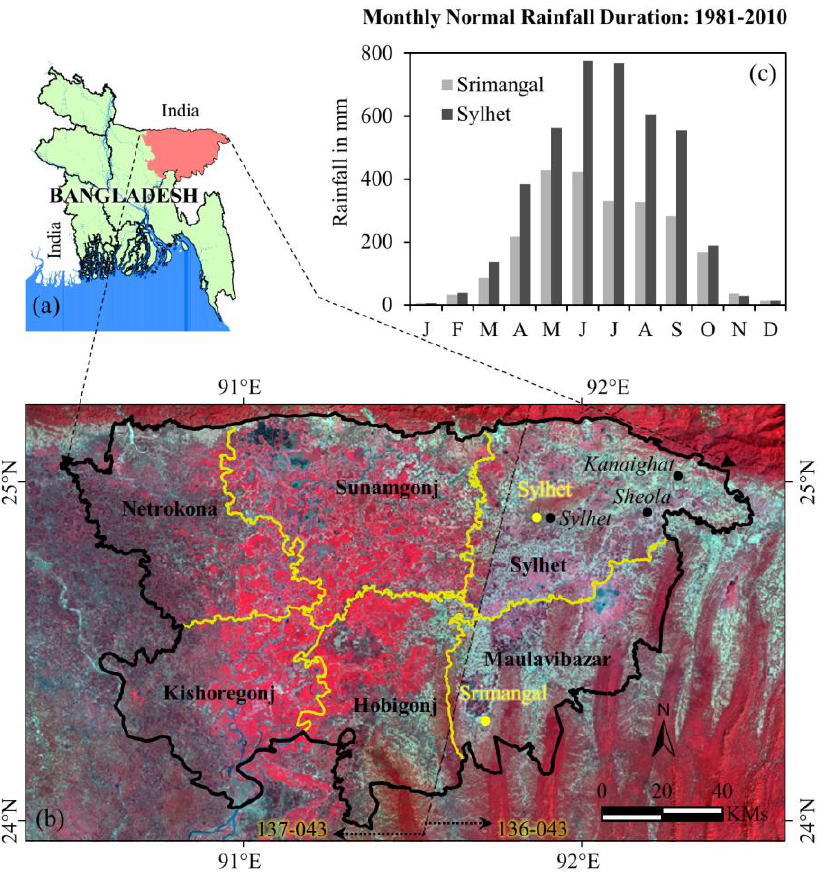
Figure 1. Map showing the spatial extent of the study area in Bangladeshi context ( a , b ), where the black and yellow polygons in ( b ) show the boundaries of the study area and individual district respectively. Additionally, the monthly normal rainfall distributions during the period 1981–2010 at Sylhet and Srimangal weather stations [yellow points in ( b )] are shown in ( c ); and locations of water level measured above danger level during the flooding event are shown as black points in ( b ).